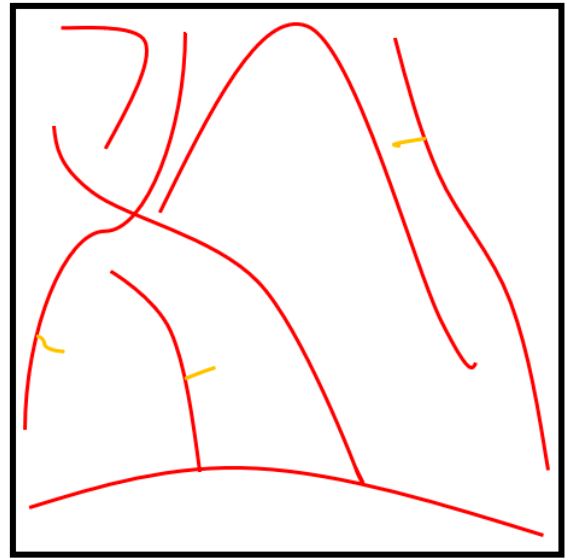
Figure 3. Pruning operation.